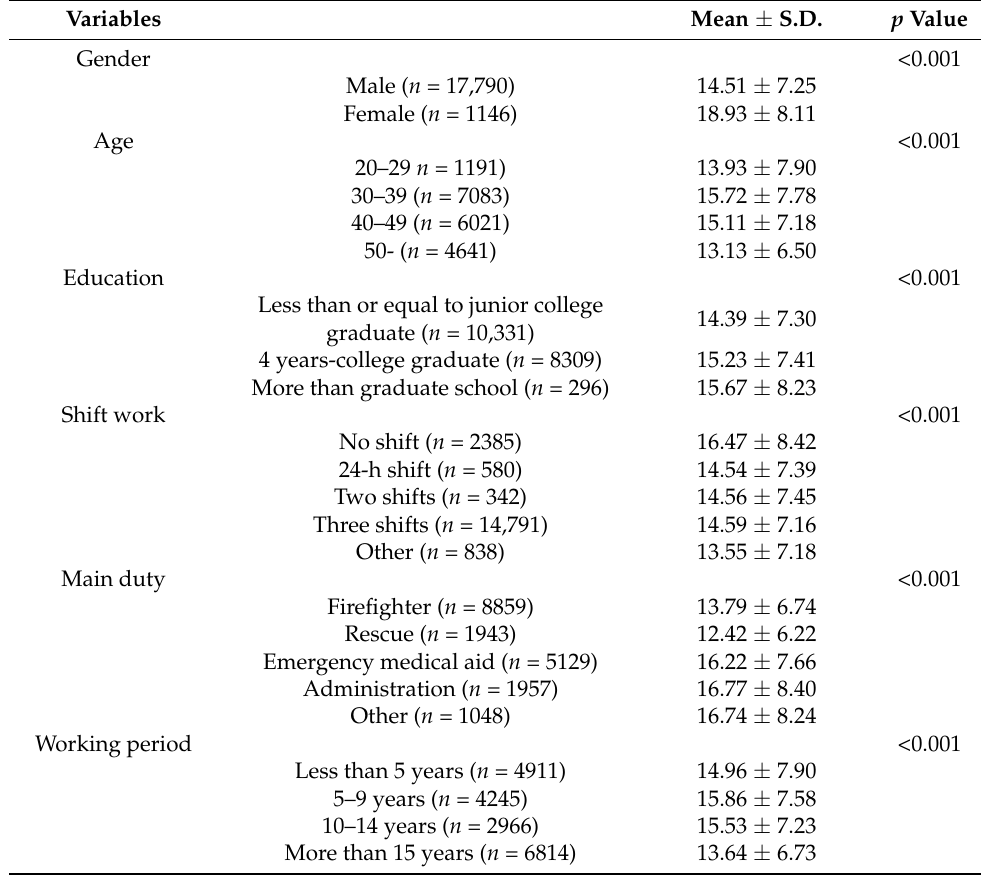
Table 1. Mean values and standard deviations of burnout according to the socio-demographic and job